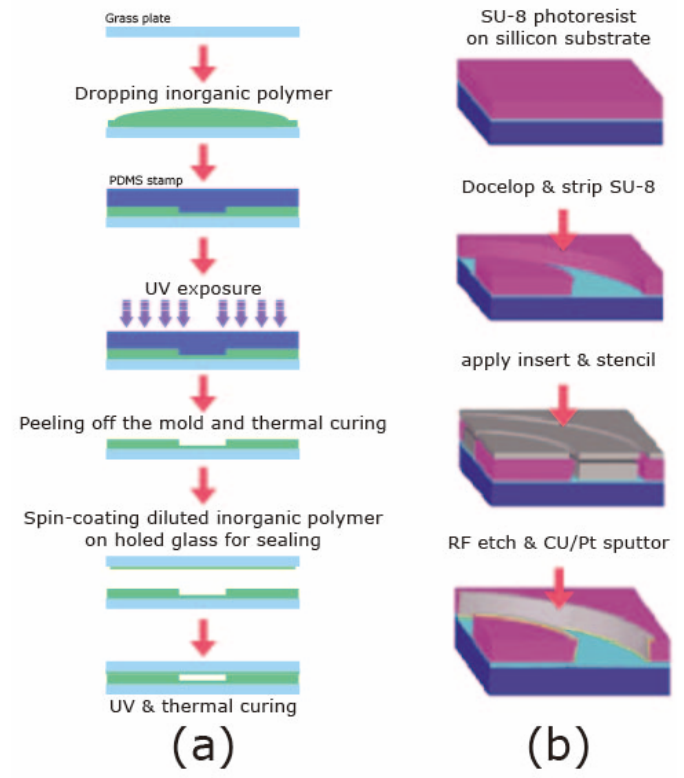
Figure 2. ( a ) Using PDMS materials for the manufacture of microreactors [76] . ( b ) Wet etching application in Pyrex glass with microchannels made of silicon layers [77] .